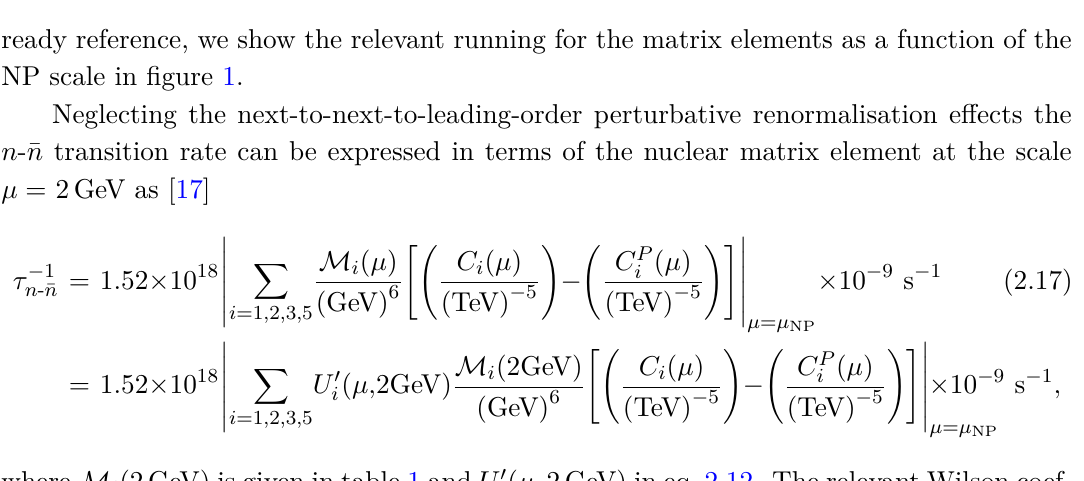
Figure 1 . Running of the relevant transition matrix elements with respect to the NP scale µ NP . The dashed line represents the central value, and the width shows the errors added in quadrature as tabulated in table